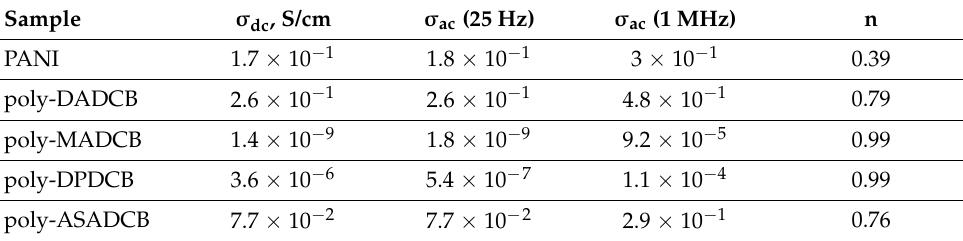
Table 2. Electrical properties of polymers.